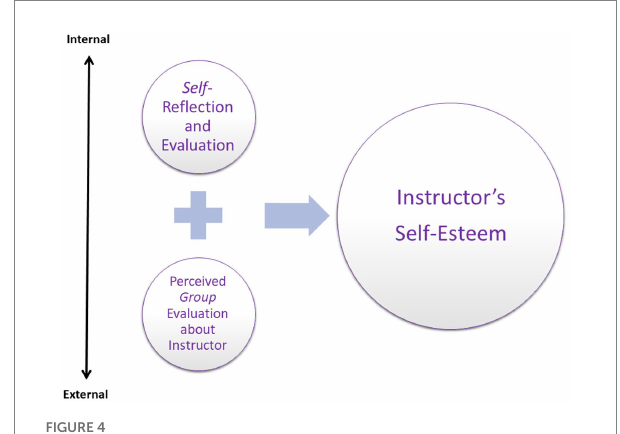
FIGURE 4 SBL instructors’ Fourth level of MHN: Self-Esteem Needs. The two sources that nurture the instructor’s self-esteem needs, as they emerged from instructors’